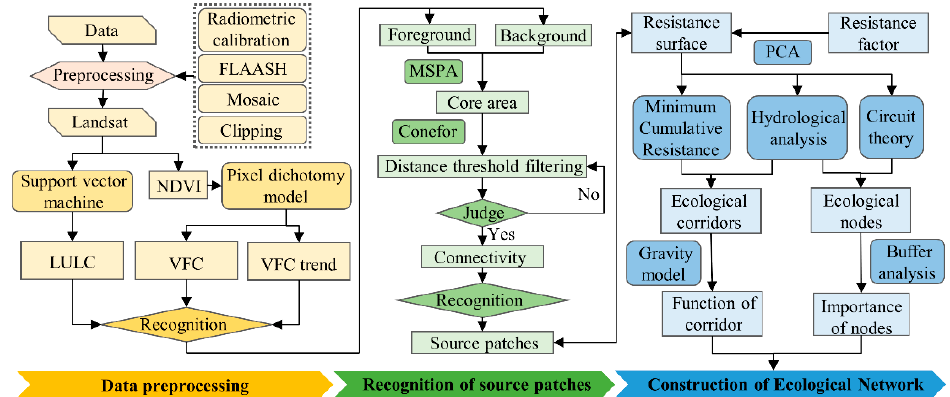
Figure 2. Technical flow chart. The meanings of the abbreviations are as follows: FLAASH is the fast line-of-sight atmospheric analysis of spectral hypercubes; NDVI is the normalized difference vegetation index; LULC is land-use/land-cover; VFC is the vegetation fractional coverage; MSPA is morphological spatial pattern analysis; PCA is principal component